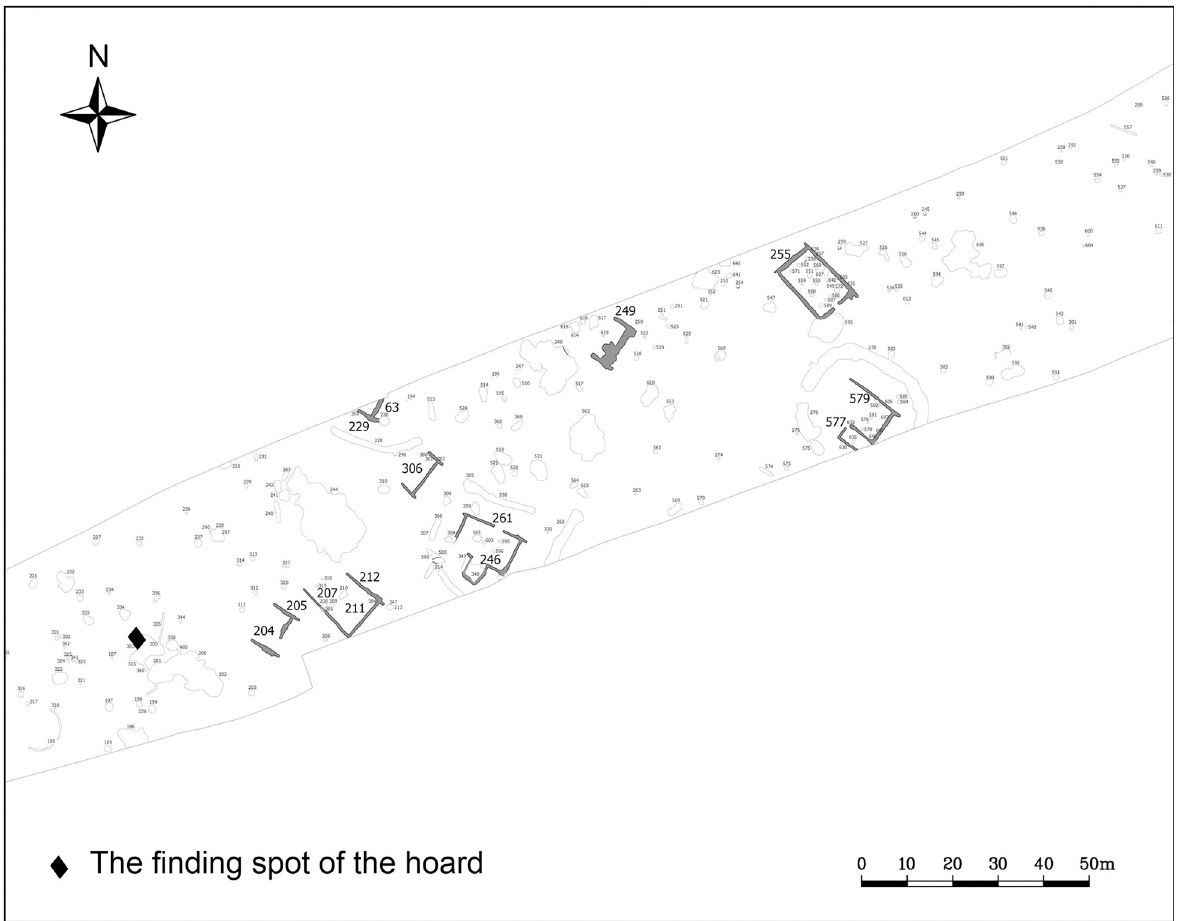
Fig 2. Location of the hoard at the site. Drawing: Archeoland Kft. (stratigraphic unit no. 383). The vessel felt unusually heavy (11.4 kg) upon excavation, there-